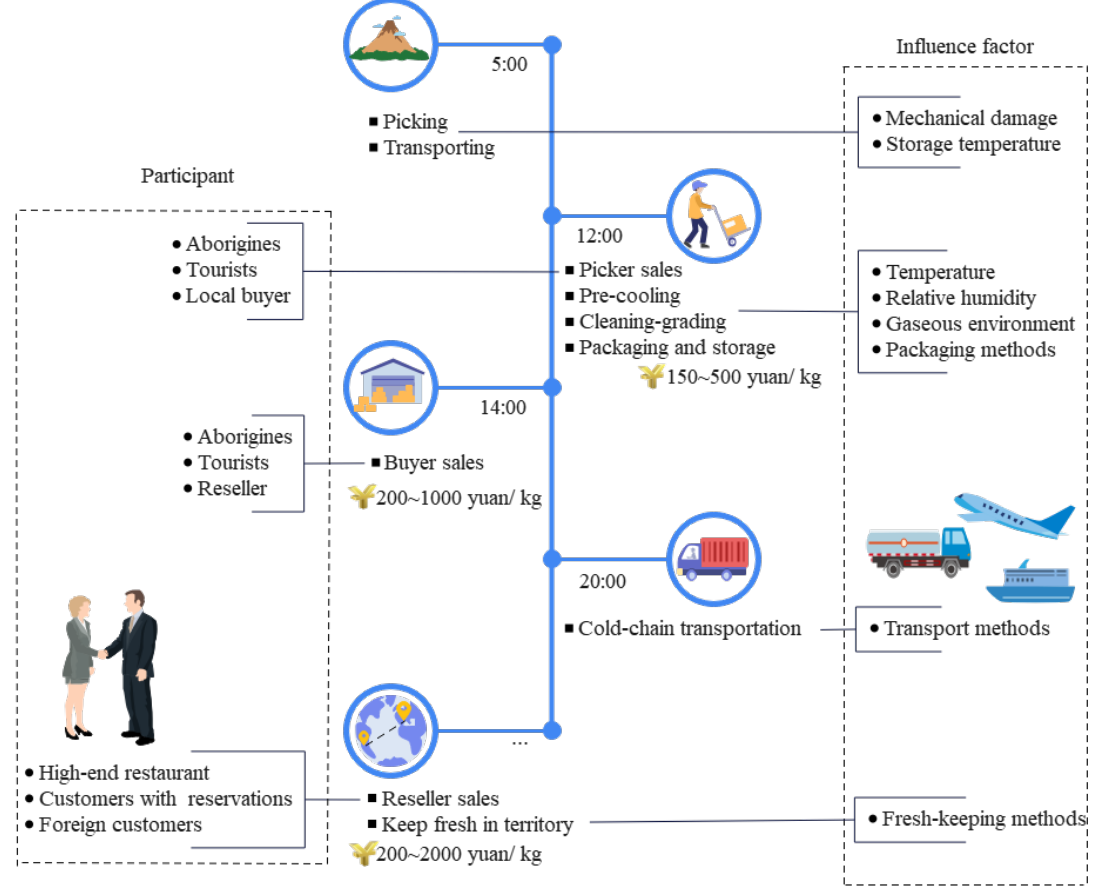
Figure 1. Tibetan matsutake post-harvest logistics flow chart.